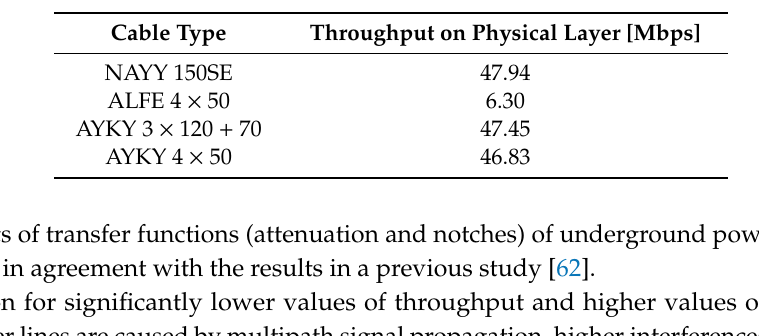
Table 2. Possibility of communication—without